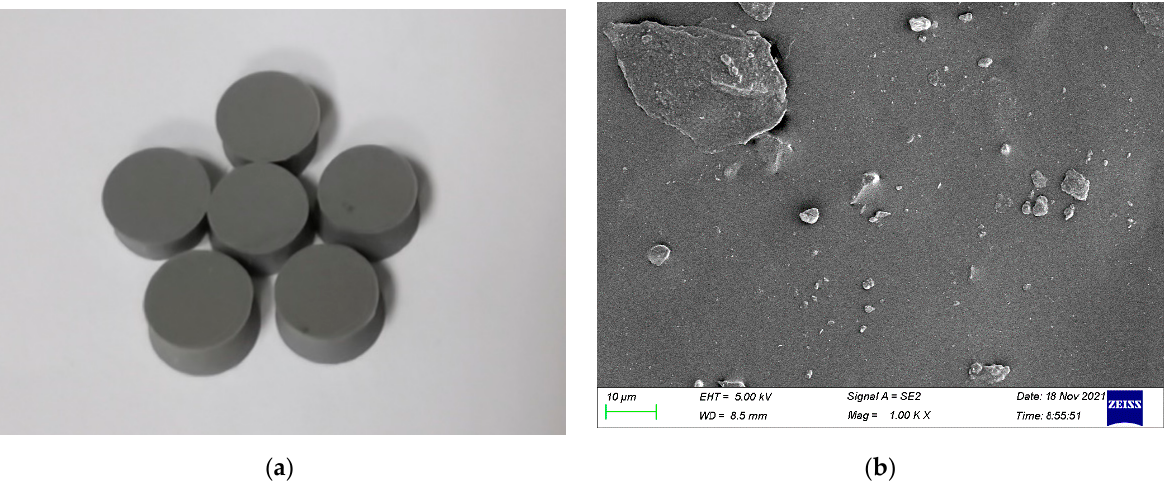
Figure 4. Silicone rubber sample: ( a ) The apparent morphology of the silicone rubber; ( b ) SEM micrograph of the silicone rubber.